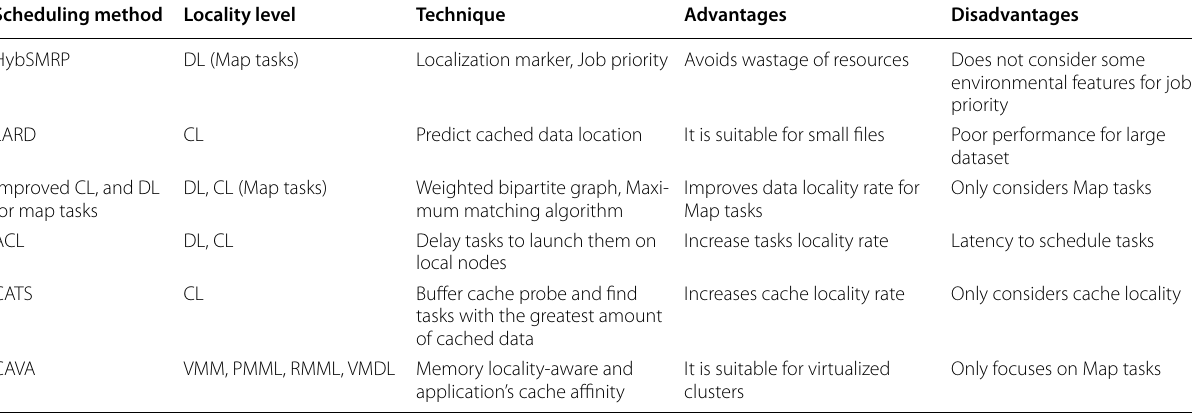
Table 1 Job scheduler comparisons Scheduling method Locality